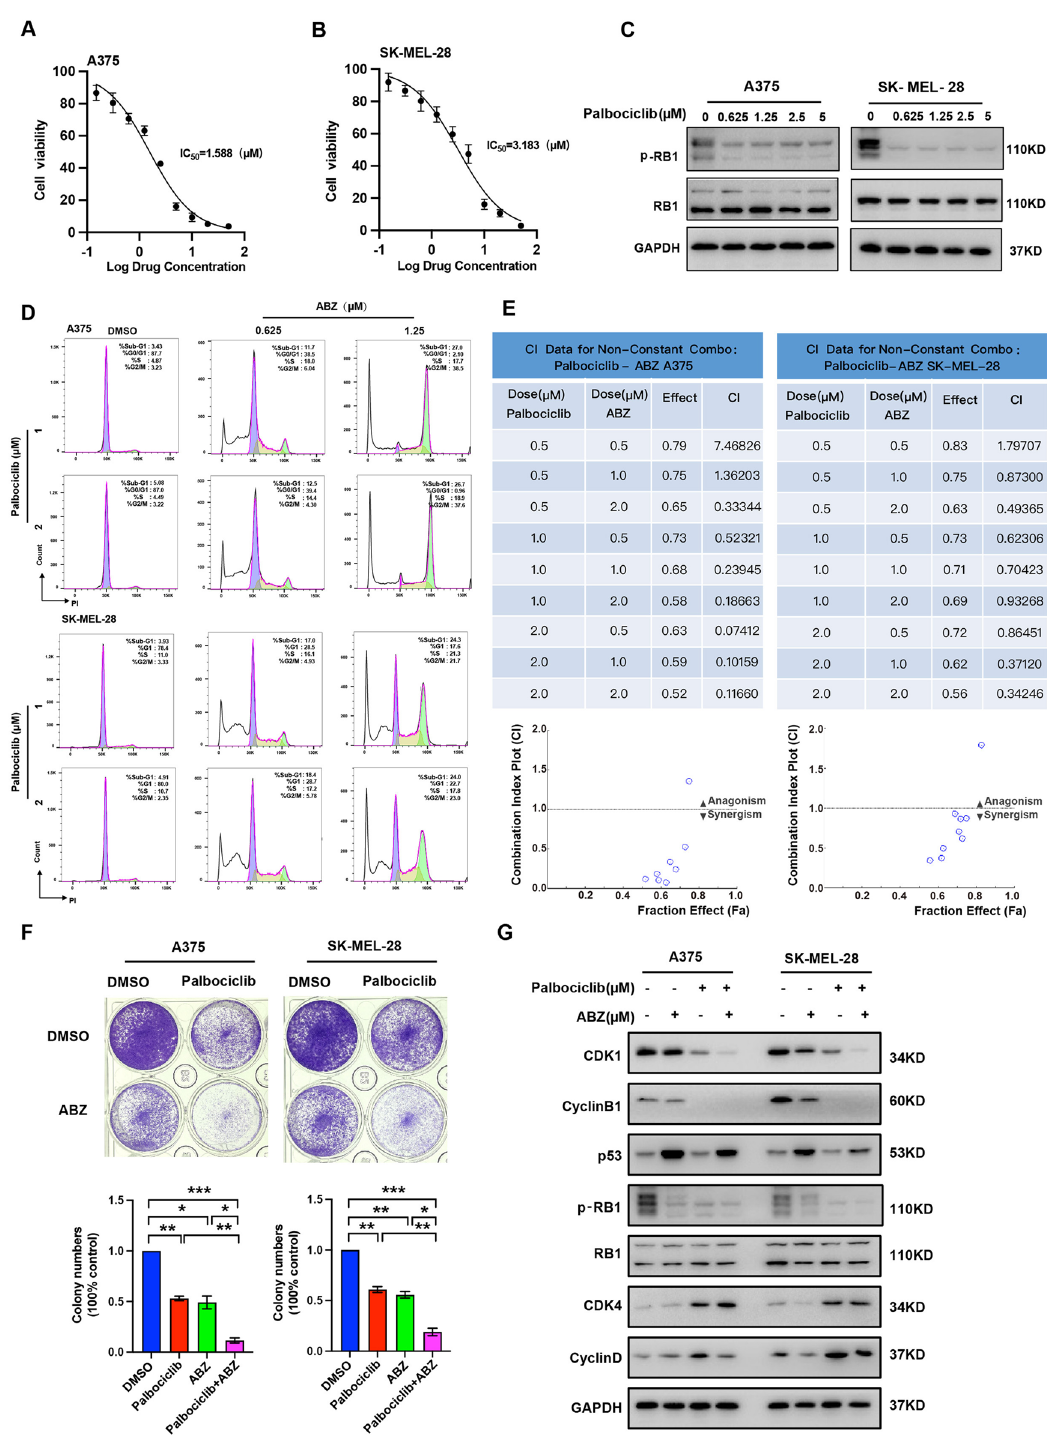
Figure 3. ABZ plus palbociclib synergistically suppresses cell growth in vitro . A375 ( A ) and SK-MEL-28 ( B ) cells were treated with various doses of palbociclib for 3 days, and an MTT assay was performed to determine cell survival. These data were used to calculate IC50 values. ( C ) Representative image (full-length gels were presented in Supplementary Figure 2) of western blot analysis of p-RB1 and RB1 in A375 and SK-MEL-28 cells after treatment with the indicated doses of palbociclib. GAPDH was used as the loading control. ( D ) Representative image of flow cytometry analysis of the cell cycle in A375 and SK-MEL-28 cells after co-treatment with the indicated doses of ABZ and palbociclib. ( E ) A375 and SK-MEL-28 cells were treated with different concentrations of ABZ, palbociclib, or ABZ plus palbociclib for 2 days, and cell viability was assessed using the MTT assay. Combination index (CI) values were analyzed using CompuSyn software for a nonconstant drug ratio, where CI < 1 indicates synergism. ( F ) The number of colonies that formed from A375 and SK-MEL-28 cells was evaluated 12 days after treatment with ABZ (0.5 μM), palbociclib (1 μM), or ABZ (0.5 μM) plus palbociclib (1 μM). The results are presented as the mean ± SD of three independent experiments, * p < 0.05, ** p < 0.01,*** p < 0.001. ( G ) Representative image (full-length gels were presented in Supplementary Figure 3D) of western blot analysis of CDK1, Cyclin B1, p53, p-RB1, RB1, CDK4 and Cyclin D in A375 and SK-MEL-28 cells after treatment with the indicated doses of palbociclib. GAPDH was used as the loading